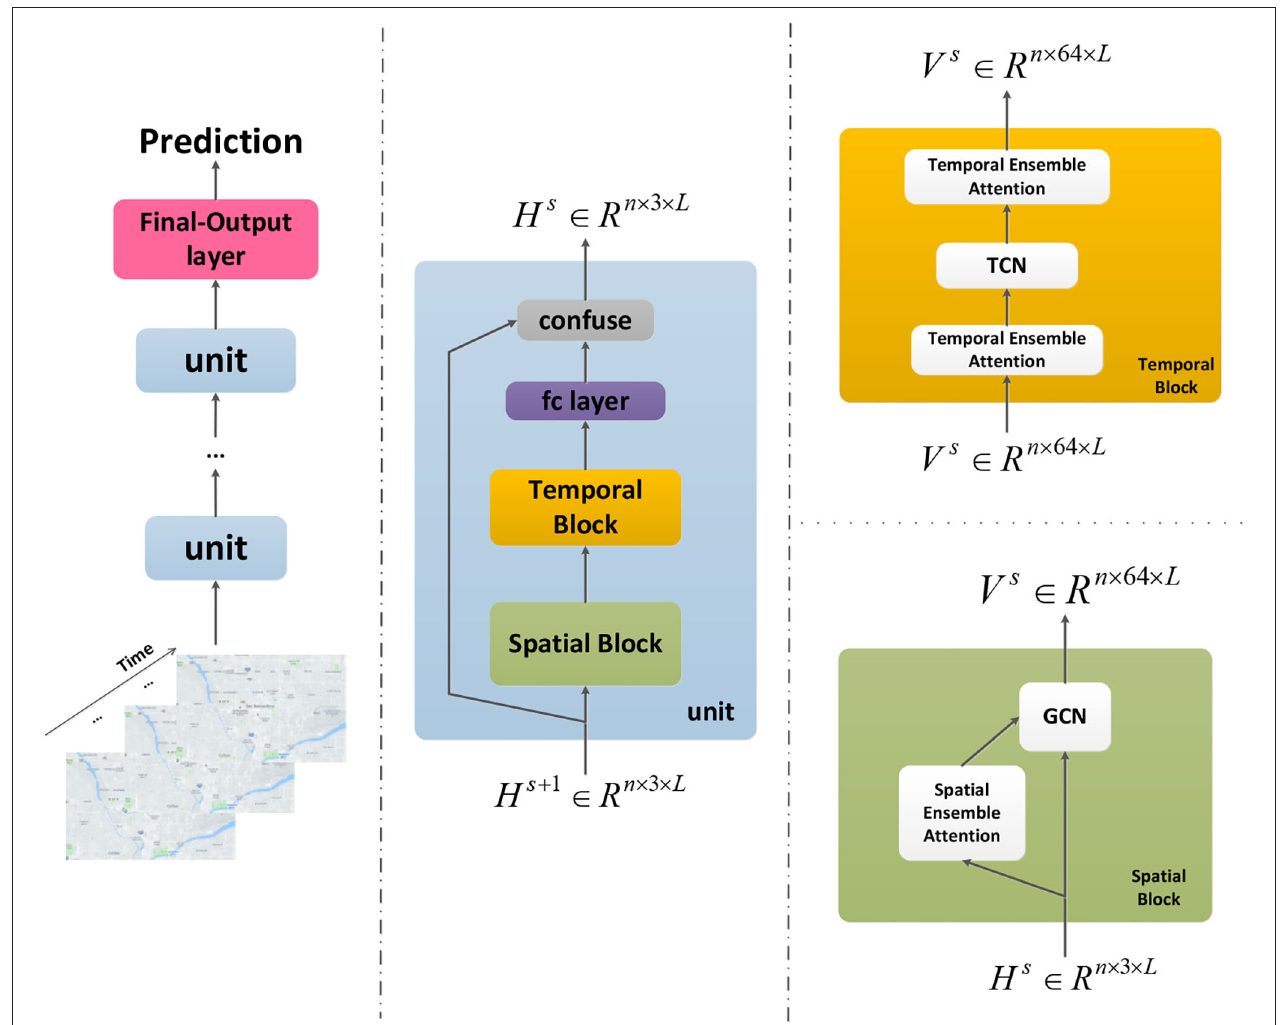
FIGURE 3 | The framework of our